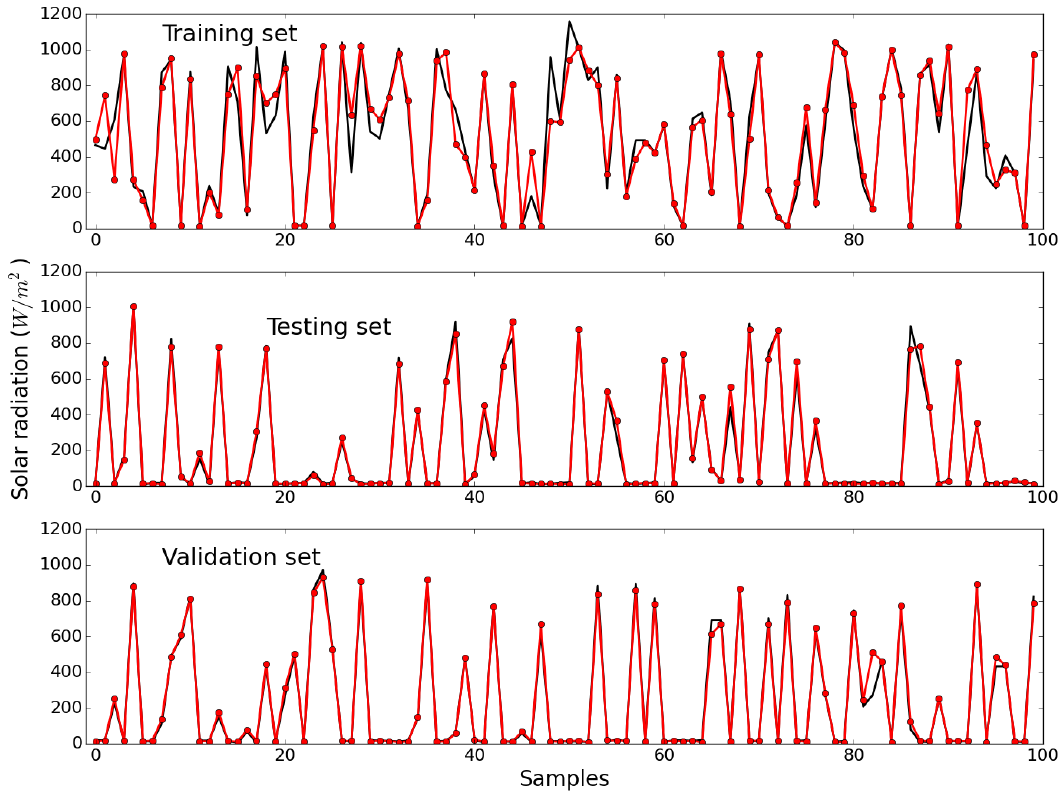
Figure 11. Measured ( black ) and estimated ( red ) values of solar radiation, for the first 100 samples of the training ( Top ); testing ( Middle ); and validation ( Bottom ) data sets.